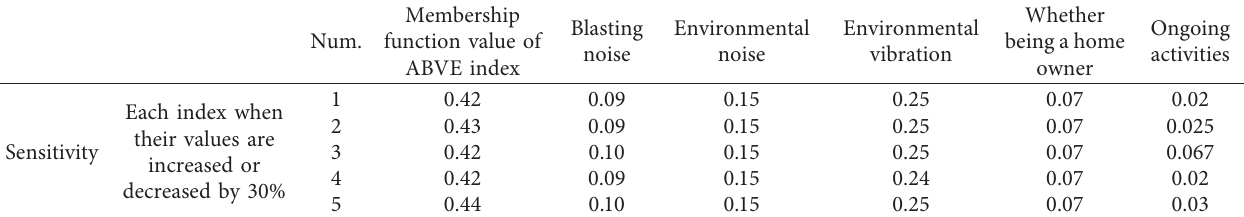
Table 9: The sensitivity of each index when their values are increased or decreased by 30%. Num.